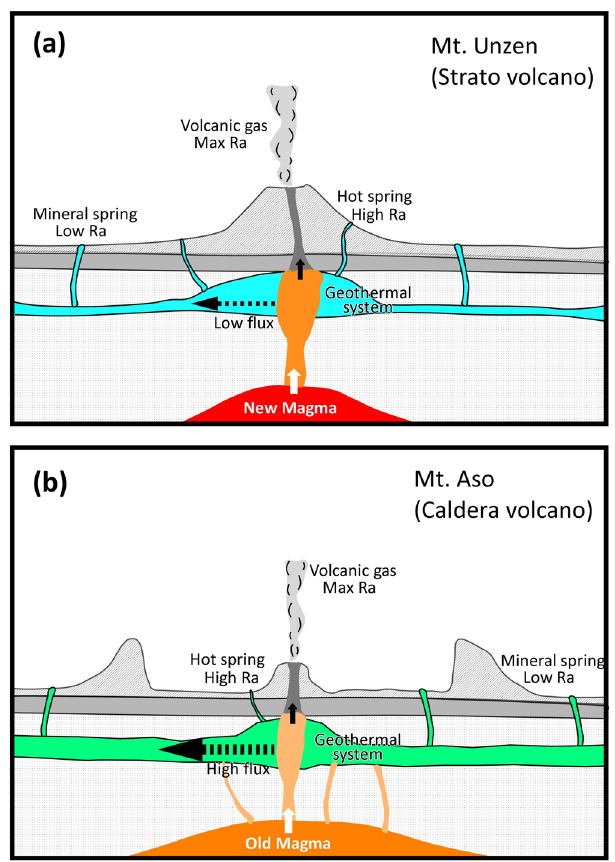
Fig. 4 Schematic diagram of the structure of a stratovolcano and a caldera volcano. Schematic diagram of the structure of a a stratovolcano and b a caldera volcano, based on the concept of helium isotope